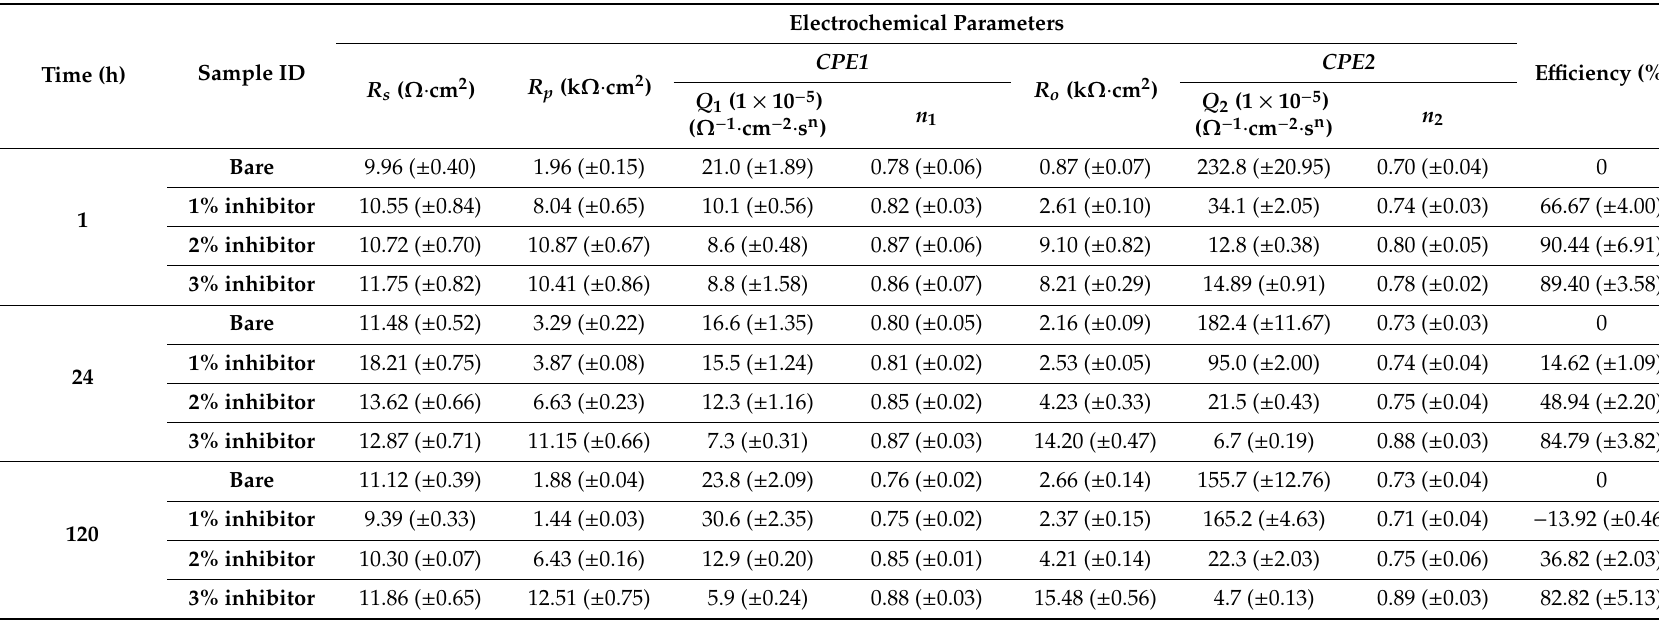
Table 3. Electrochemical parameters obtained by EIS fitting of steel rebars exposed to bare and inhibitor-added SCP + 3.5 wt% NaCl solutions for di ff erent durations.